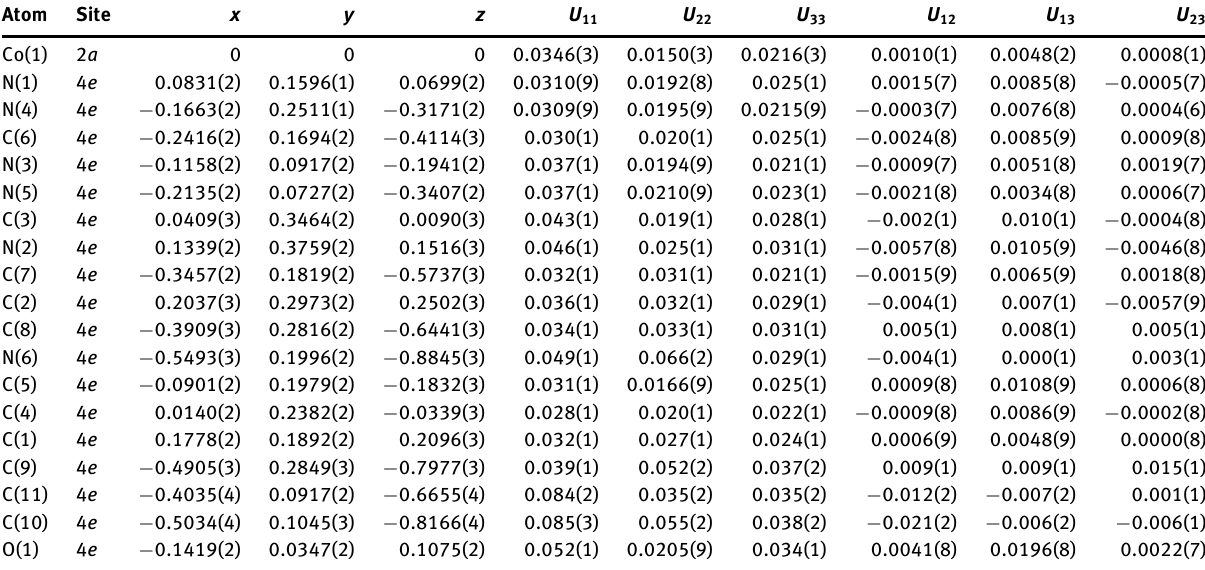
Table 3: Atomic displacement parameters (Å 2